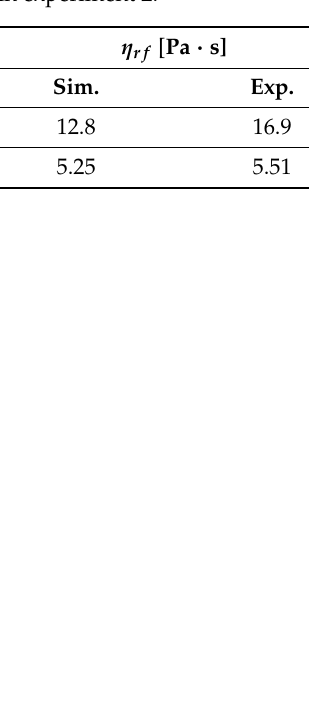
Table 4. Simulation and experimental results of outlet temperature T f and outlet reference zero-shear viscosity η rf when barrel temperature T b was 300 and 350 ◦ C in experiment 2.